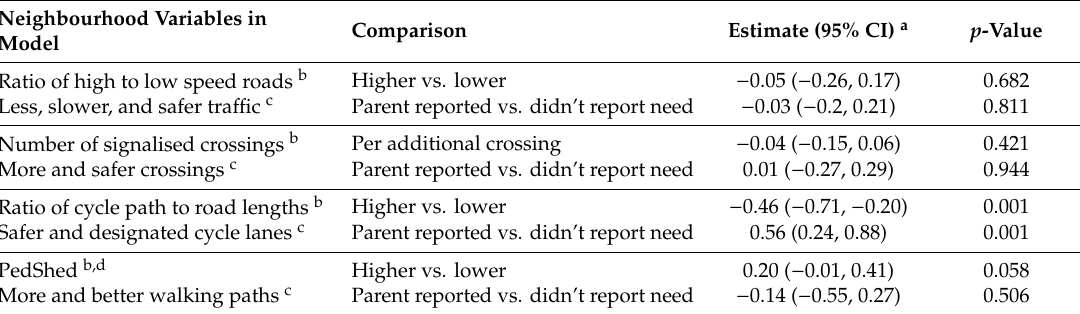
Table 6. Mutually adjusted association of parent reported needs and related objective neighbourhood features with children’s licence for independent mobility ( n =